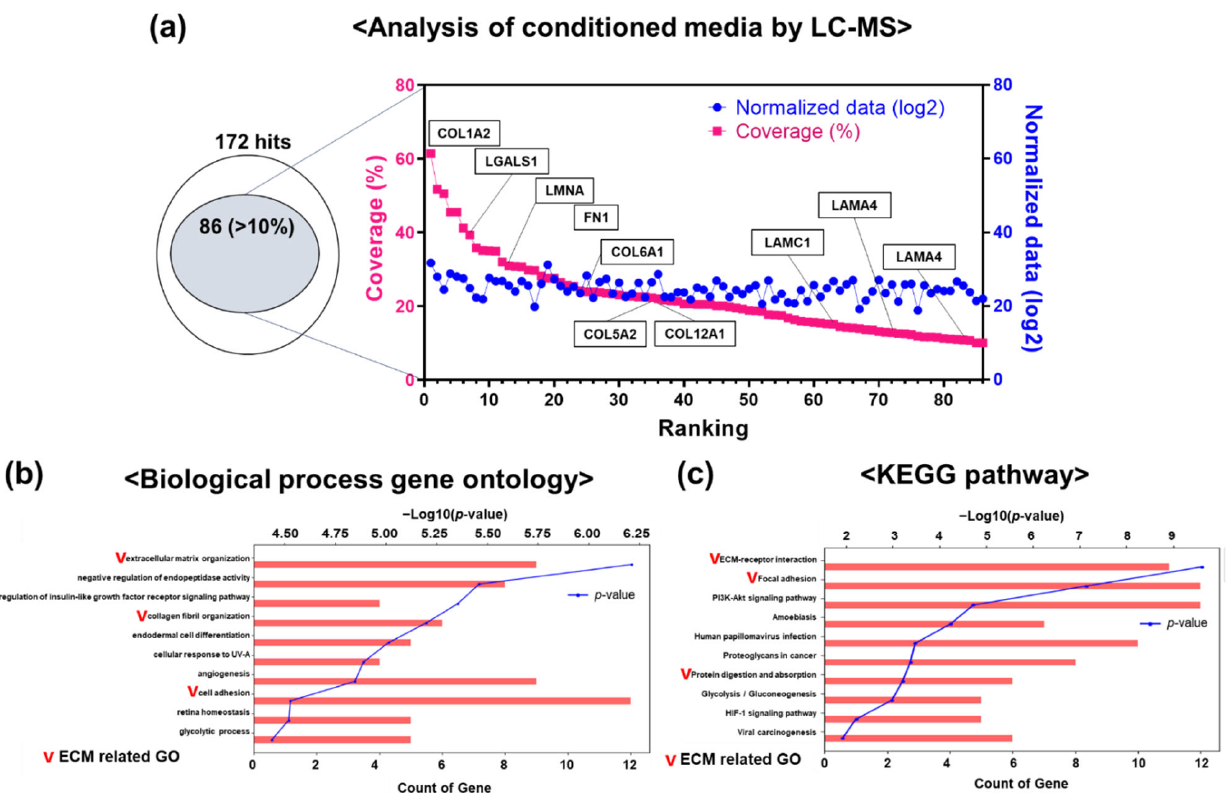
Figure 4. LC ‐ MS analysis of conditioned media from HGF. ( a ) From LC ‐ MS analysis of ten times concentrated hGF ‐ CM, 172 hits were detected. Among them, over 10% coverage was found from 85 hits, revealing extracellular matrix (ECM) proteins such as collagen and laminin. ( b , c ) Gene ontology analysis using DAVID revealed ECM ‐ related biological GO terms and pathways.